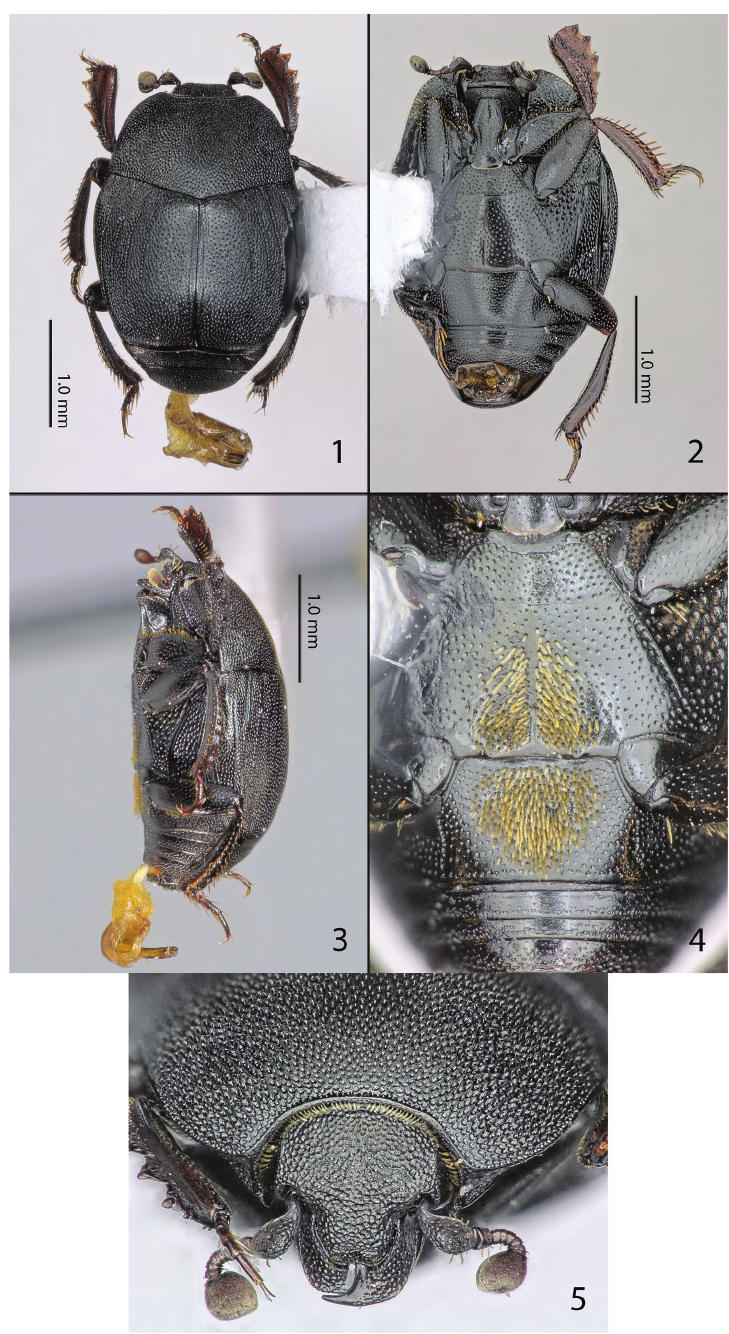
Figures 1–5. 1 Eremosaprinus warneri sp. n., habitus, dorsal view. 2 ditto, ventral view 3 ditto, lateral view 4 Eremosaprinus warneri sp. n., male, metaventrite + first abdominal ventrite 5 Eremosaprinus warneri sp. n., head, frontal